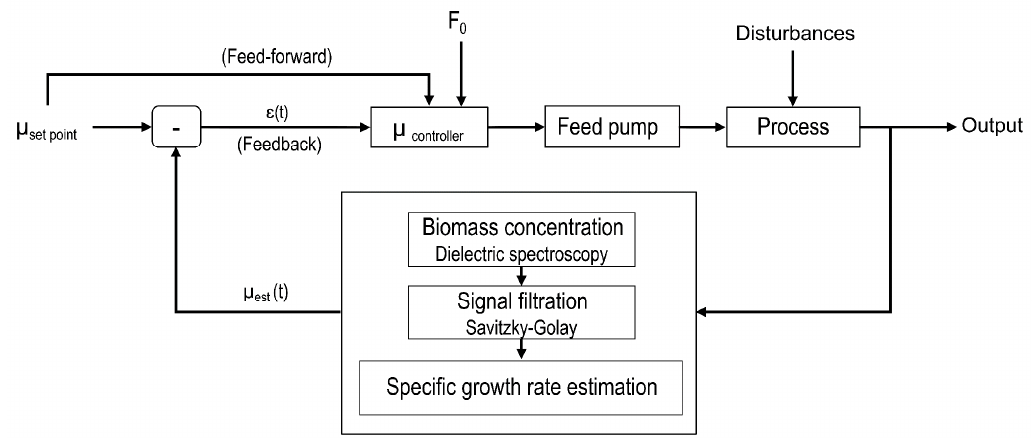
Figure 2. Controller block diagram.